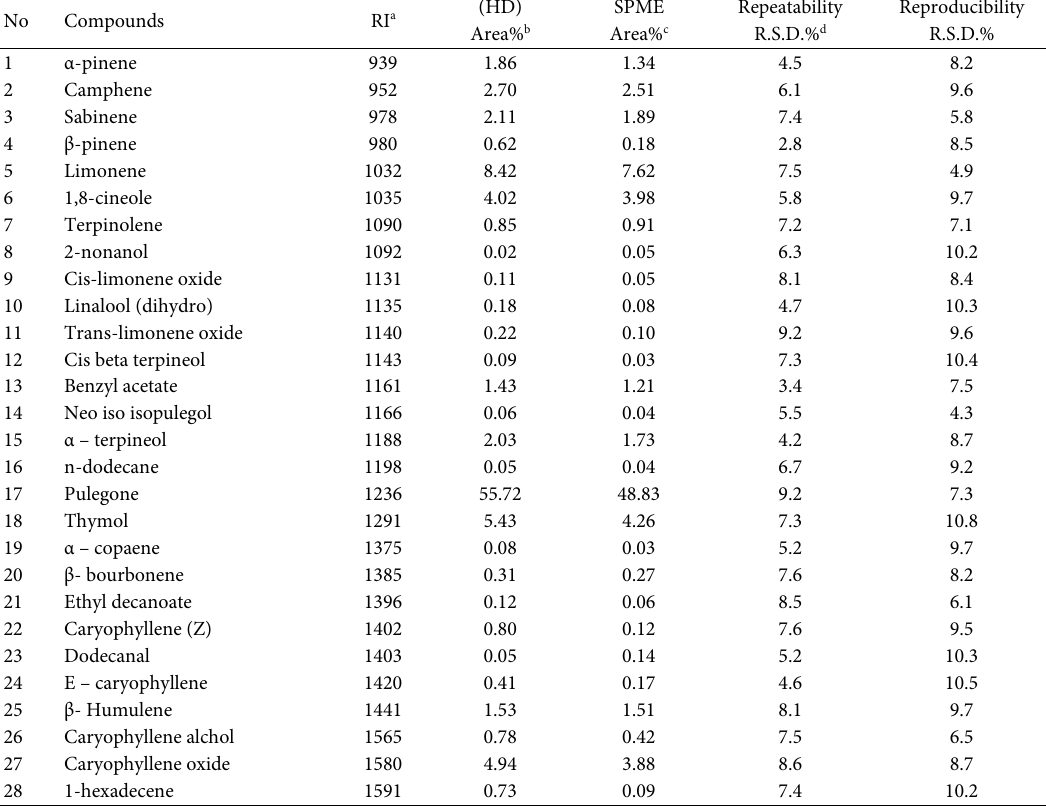
Figure 2 . Effect of water addition on the extraction efficiency of the solid-phase microextraction method.